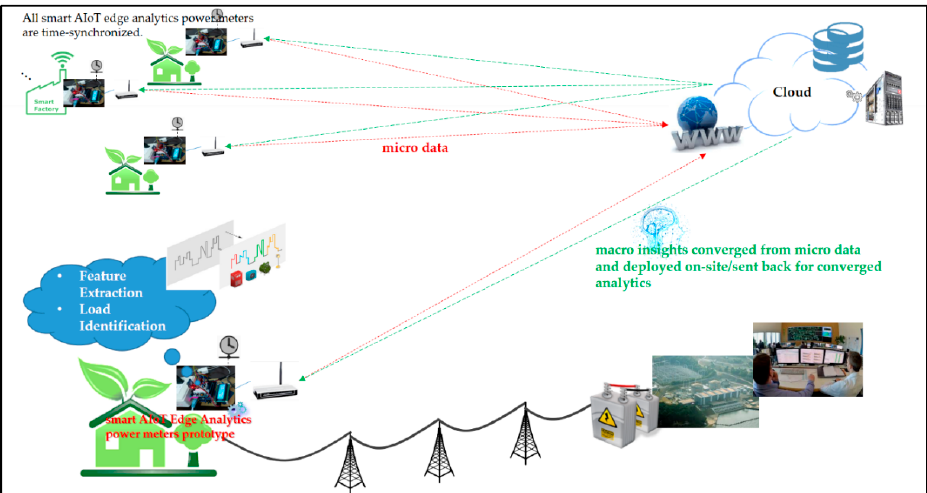
Figure 2. Conceptual vision of the presented prototype considering a future user-centric Internet of things (IoT) application, based on fog-cloud analytics, for demand-side management DSM in a smart grid (SG). Advances, user-centric IoT service-oriented single and/or multiple sensing modalities, for DSM in an SG and many others in a smart city can build upon this infrastructure.